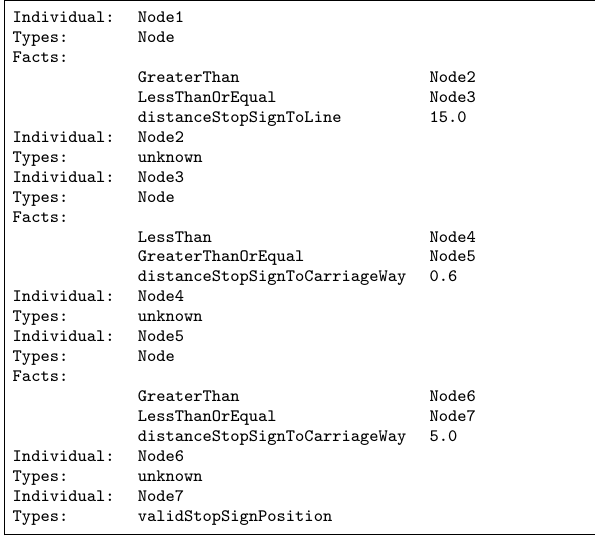
of the centreline. However, only the east-south exit shows a har- monised data set with matching coordinates, whereby the other three exits do not share a path (yellow to blue polylines and yel- low to cyan polylines). In this example, the data set LGATE-195 (yellow polylines) represents the centreline slightly with an off- set to the red coloured pavement. The corresponding MRWA-515 data set (blue and cyan polylines) shows the road hierarchy con- nected to the road stopping places. The distance of about 5.4 m indicated in pink between the centrelines is calculated using the haversine formulae described in MTL (2018) to derive the great circle distance ( d ) between two